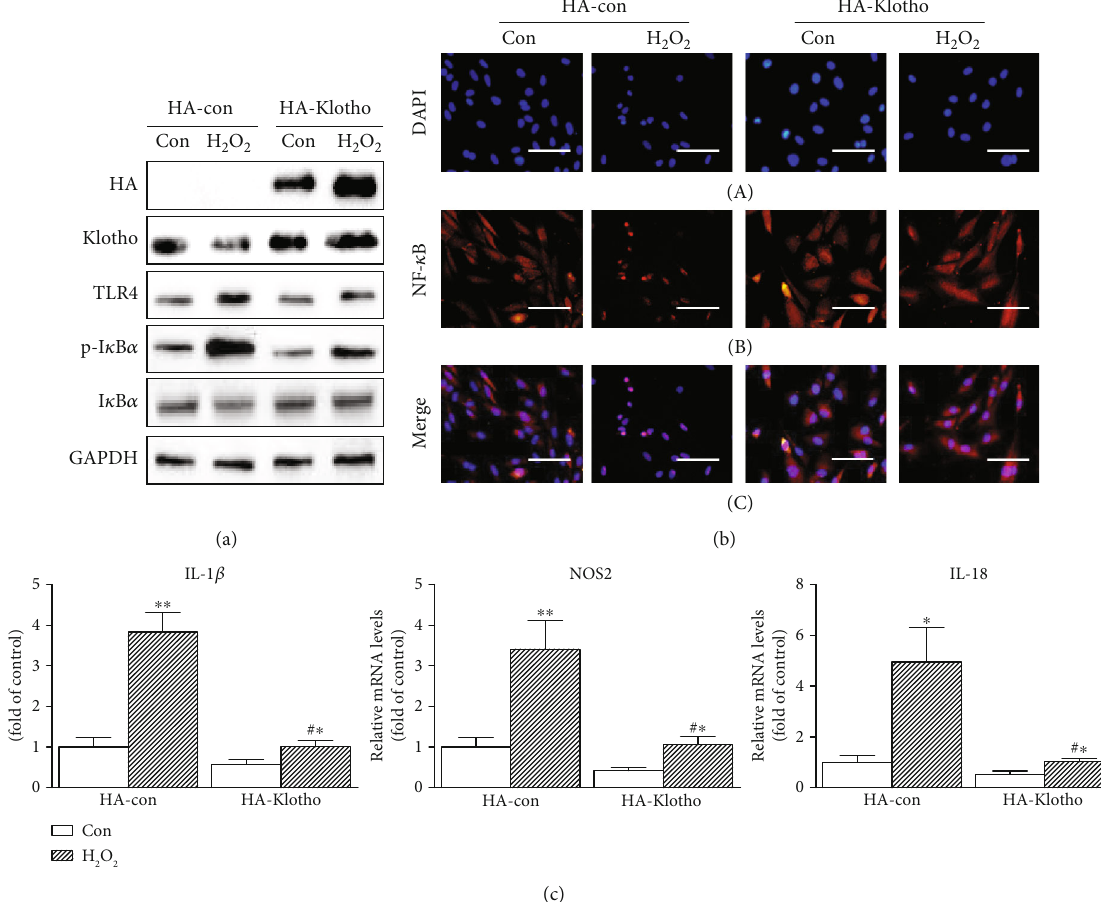
Figure 4: Klotho suppression of the TLR4-NF- κ B signaling in NP cells. (a) NP cells were transfected with HA-con and HA-Klotho plasmid for 24h, then treated with H O (200 μ M) for 12 h. The overexpression of HA-tagged Klotho was veri fi ed with an anti-HA antibody. Cell 2 2 lysates were tested for Klotho, TLR4, p-I κ B α , and I κ B α expressions by Western blotting. (b) Immuno fl uorescent staining of NF- κ B nuclear translocation. NP cells transfected and treated as in Figure 4(a) for 30min were stained with anti-NF- κ B antibody (B), counterstained with DAPI (A), and the fi gures were merged (C). Scale bar, 20 μ m (original magni fi cation × 40). (c) NP cells transfected and treated as in Figure 4(a) for 6 h were tested for IL-1 β , NOS2, and IL-18 mRNA levels by qRT-PCR. GAPDH served as an internal control. The results were presented as mean ± SD of three independently performed experiments. ∗ P < 0 : 05 , ∗∗ P < 0 : 01 vs. control. # P < 0 : 05 vs. H